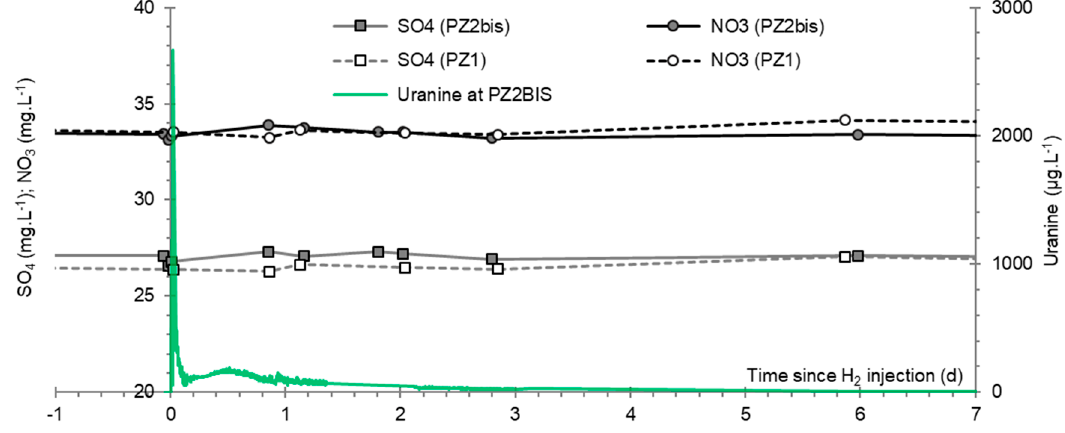
Figure 26. Comparative evolution of the concentrations of sulfates, nitrates, and tracer at PZ1 (20 m upstream) and PZ2BIS (5 m downstream) during the week following the injection of dissolved hydrogen.